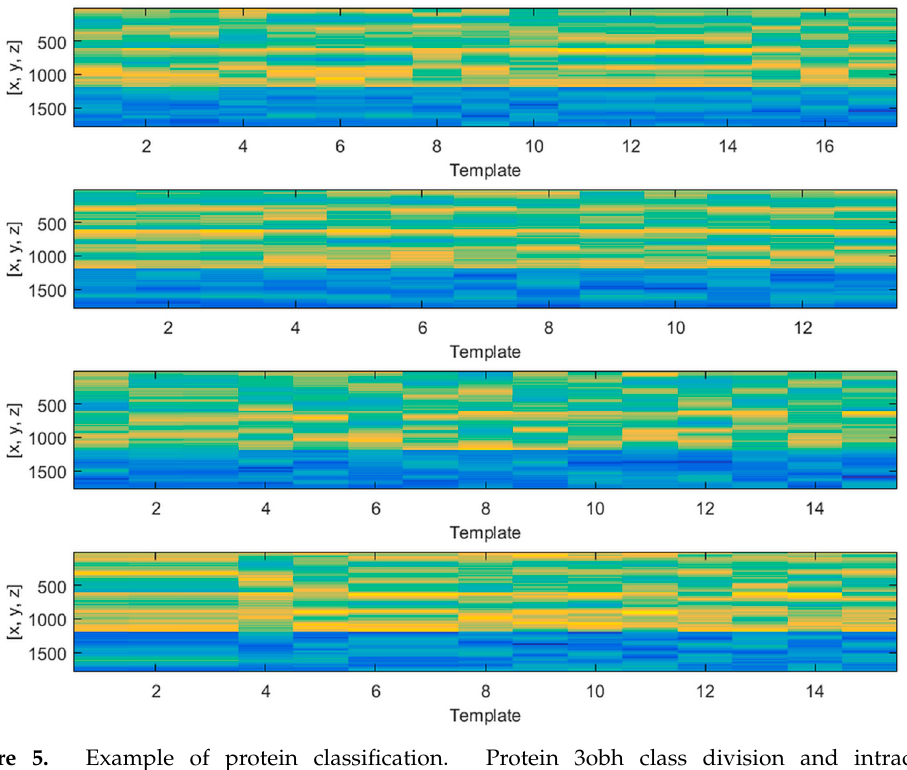
Figure 5. Example of protein classification. Protein 3obh class division and intraclass structural similarity.